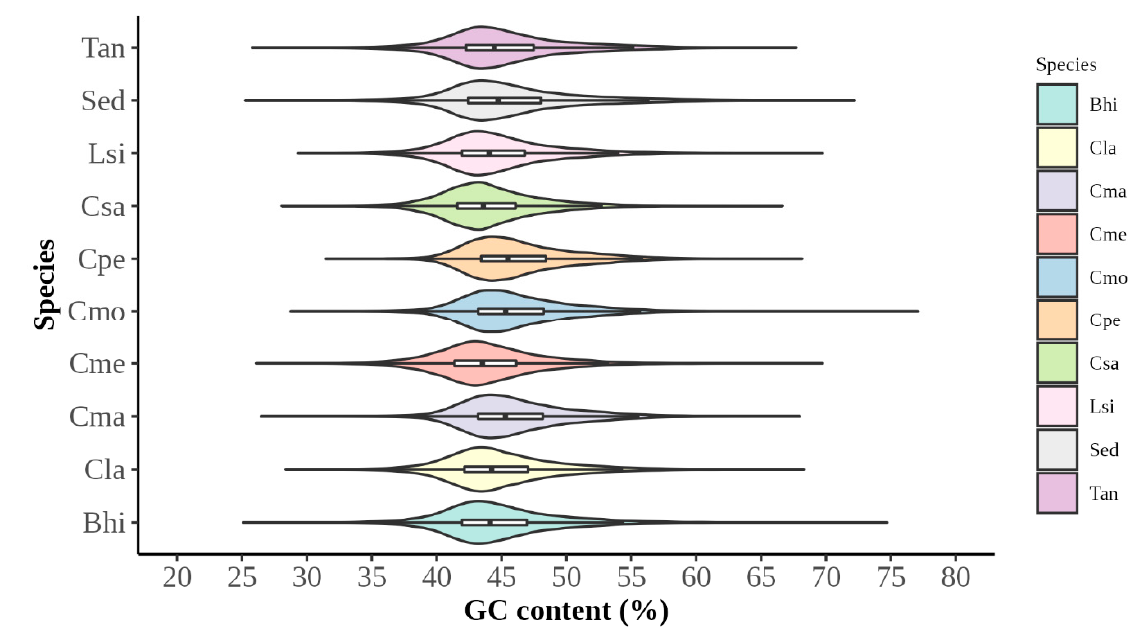
Figure 1. Distribution of the GC contents of genes in ten species of Cucurbitaceae. Note: X -axis indicates the percentage of GC contents, and Y -axis indicates each species. Abbreviations are used for species names (refer to Table 1 for details).